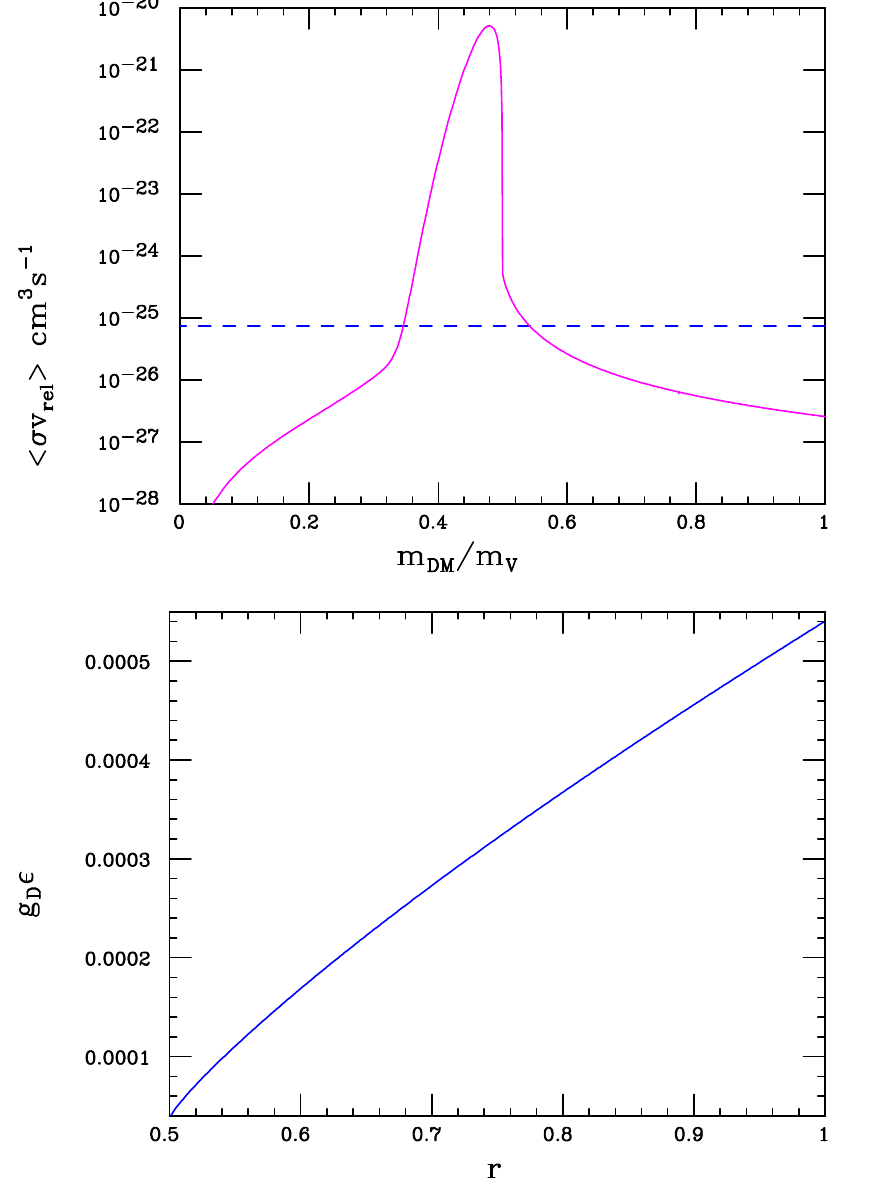
Figure 2 . (Top) Sample thermally averaged complex scalar DM annihilation cross section as a function of r = m φ /m V , assuming m V = 100 MeV and g D (cid:15) = 10 − 4 with x f = 20 . The expression in the square bracket in the text has thus been set to unity here. The corresponding results for other values of these input parameters can be obtained via simple rescaling using the equation in the text. The dashed line shows the approximate annihilation cross section needed to obtain the observed relic density and thus for any r = m DM /m V in our range of interest the required value of g D (cid:15) can be determined. (Bottom) The value of g D (cid:15) required to obtain the observed relic density as a function of r in our range of interest assuming that m V = 100 MeV based on the results presented in the top